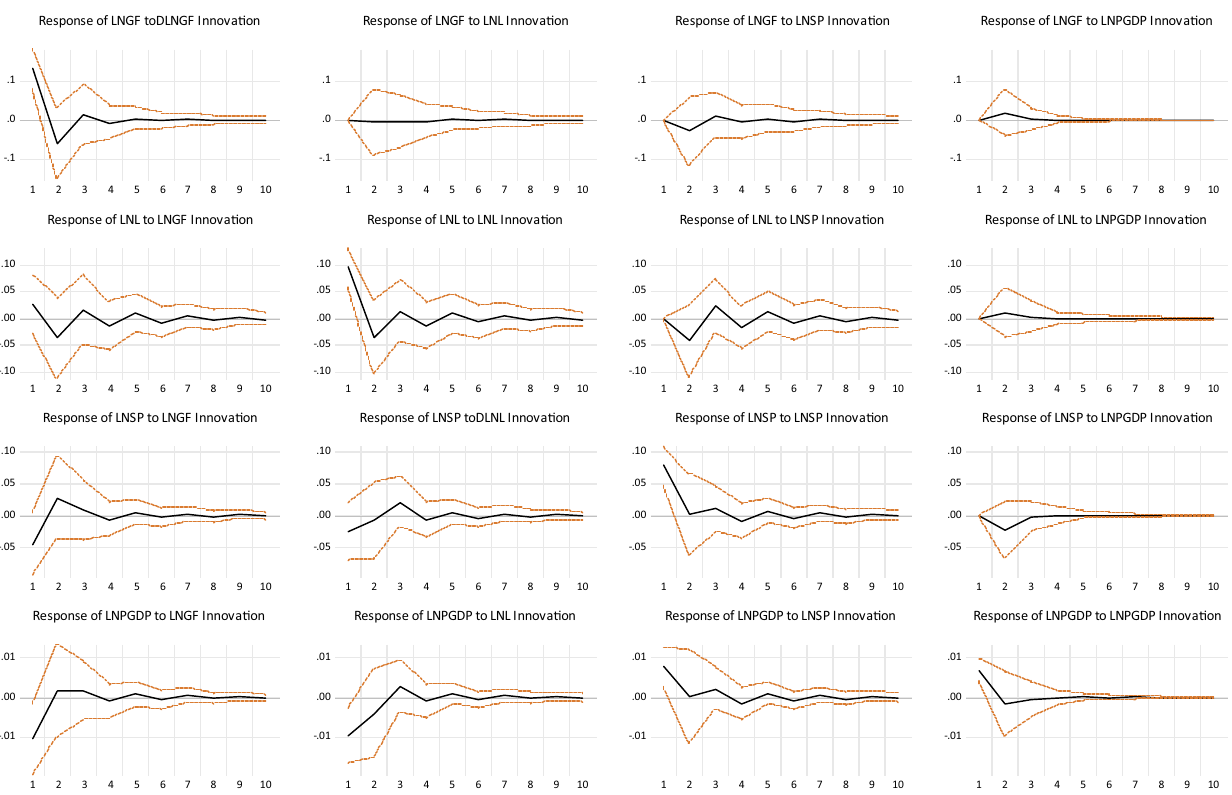
Fig. 2 The results of impulse response analysis of four variables to the short-term structural shocks. Estimates with one standard error band and the red line represents con fi dence intervals were constructed using a recursive − design wild bootstrap, and the black line represents the